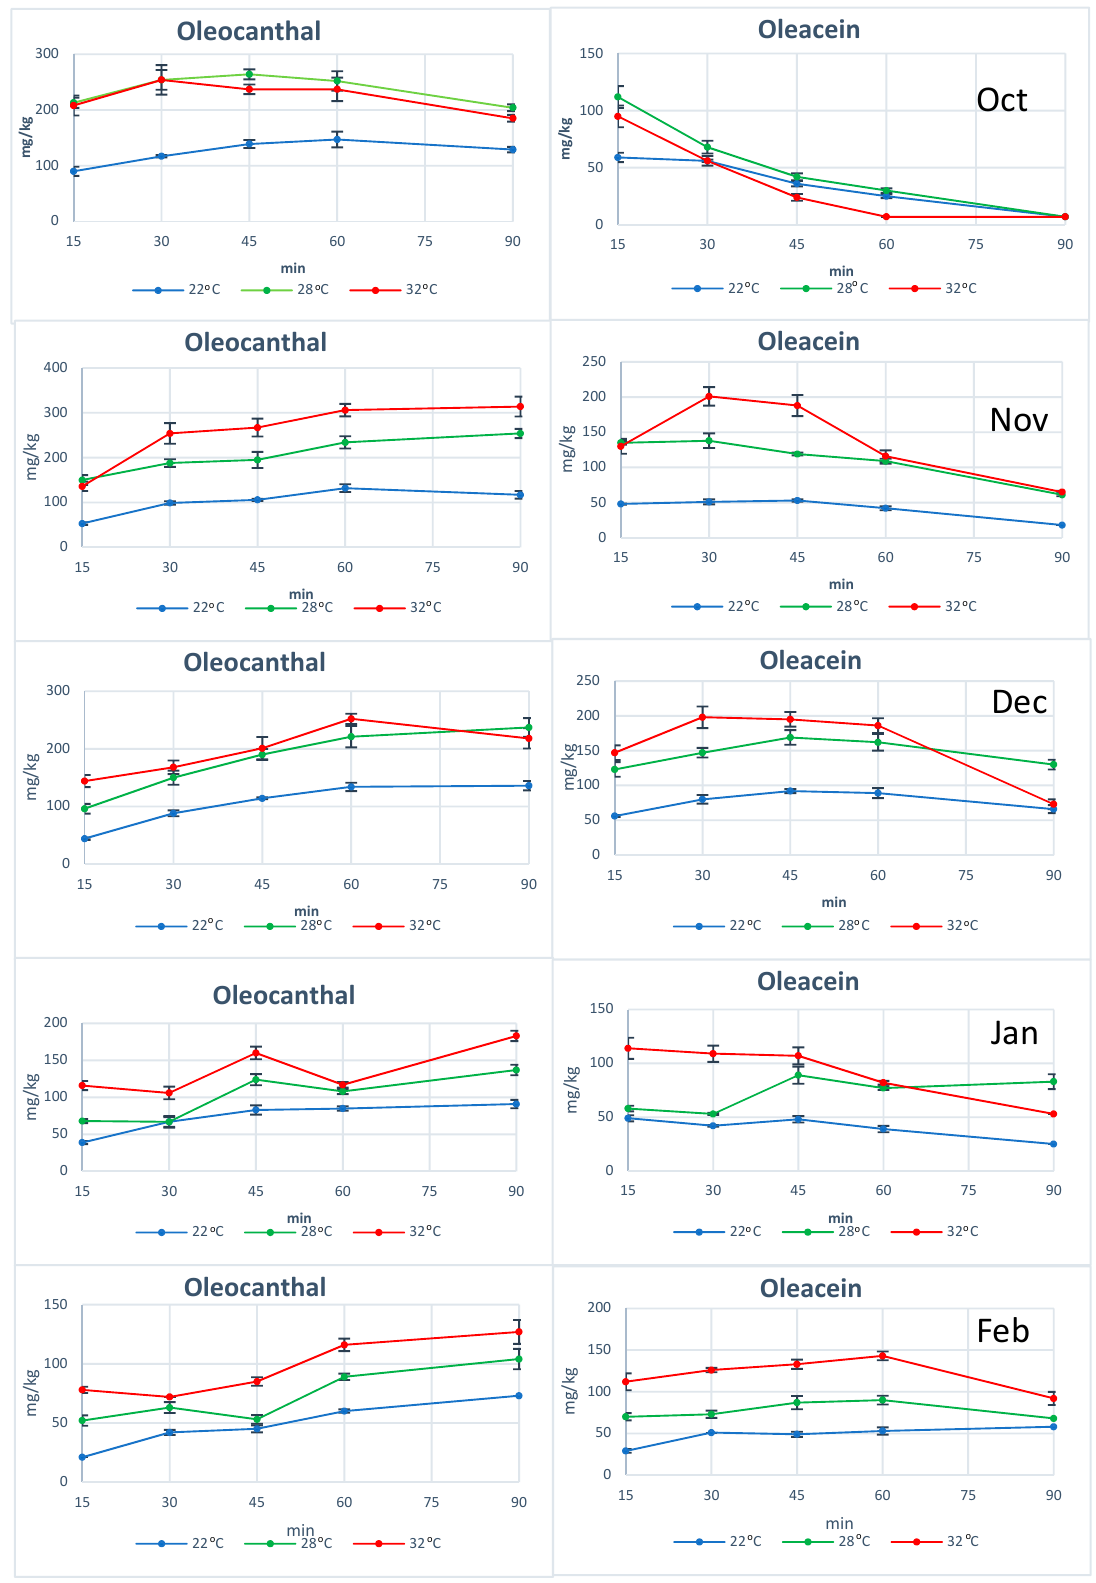
Figure 3. The concentration of oleocanthal and oleacein at five different ripening degrees during malaxation at three different temperatures.